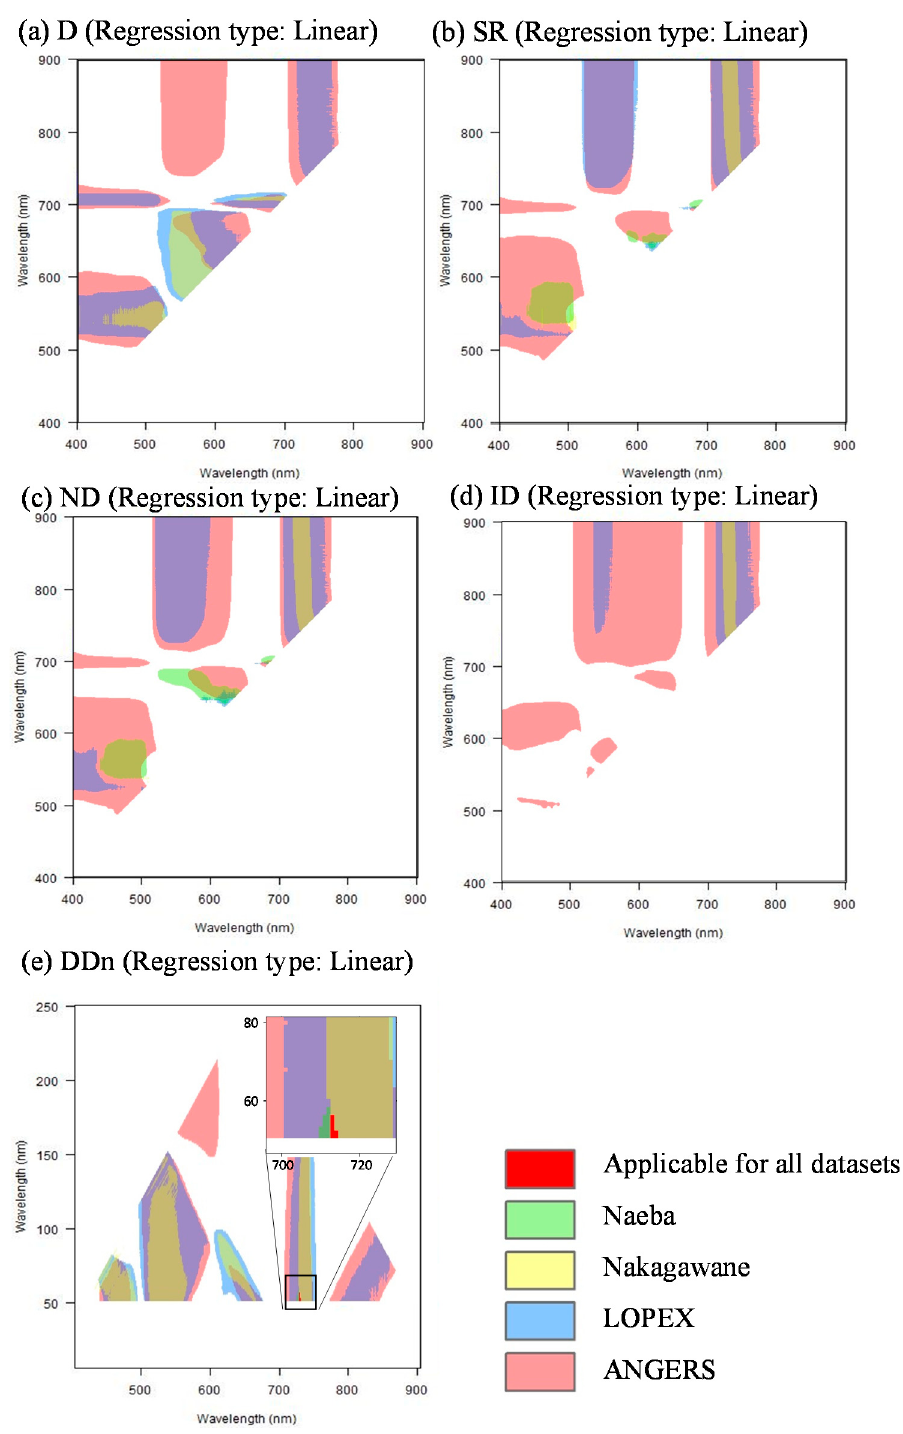
Figure 4. Categories based on ratio of performance to deviation (RPD) with different type indices using original reflectance (linear regression). D: wavelength difference; SR: simple ratios; ND: normalized difference; DDn: double differences; ID: inverse reflectance differences.